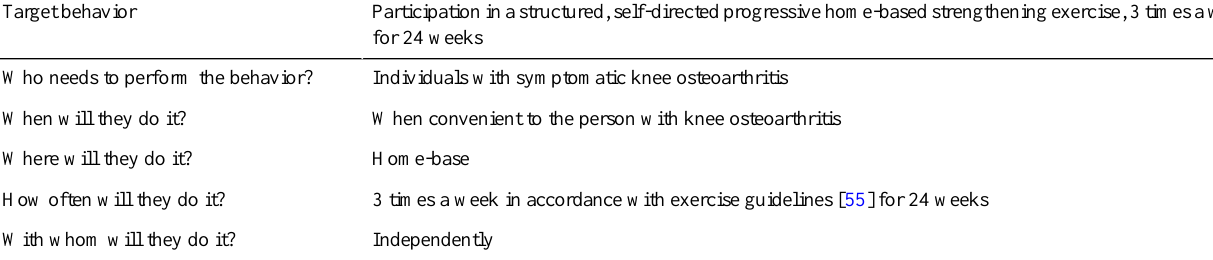
Table 1. Target behavior described in